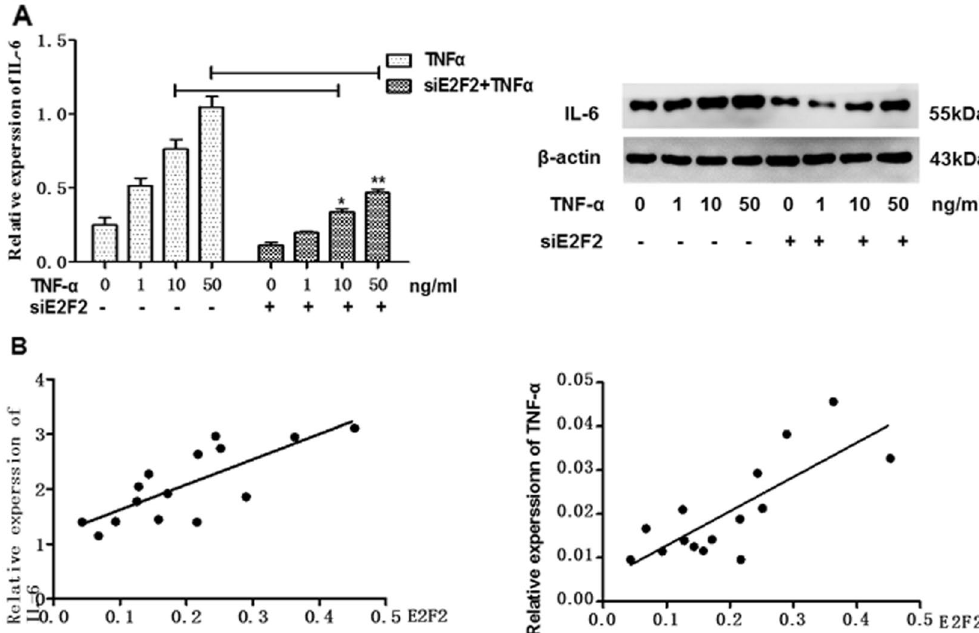
Figure 5. Effect of E2F2 on IL-6 expression and correlations between serum E2F2 and cytokine levels in patients with rheumatoid arthritis. ( A ), Effect of siE2F2 on TNF- α stimulated IL-6 expression detected by RT-qPCR (left) and Western blot (right). ( B ), Correlations between mRNA levels of E2F2 and IL-6 or TNF- α secreted into the supernatant of RASFs. qRT-PCR was used to quantify mRNA levels of E 2 F 2 , and ELISA was performed to quantify the levels and IL-6 or TNF- α respectively secreted into the supernatant of RASFs(n = 15). Pearson correlation analysis was used to assay the correlations. Values are expressed as mean ± SD of the mean and at least 3 independent experiments were performed. * P < 0.05. ** P <